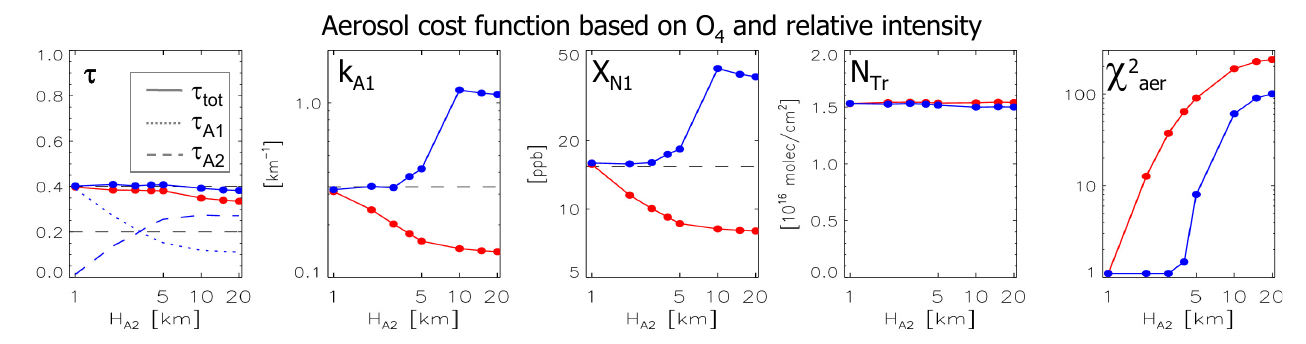
profile with a height of 0.6 km and AOT = 0.2, see also Fig.